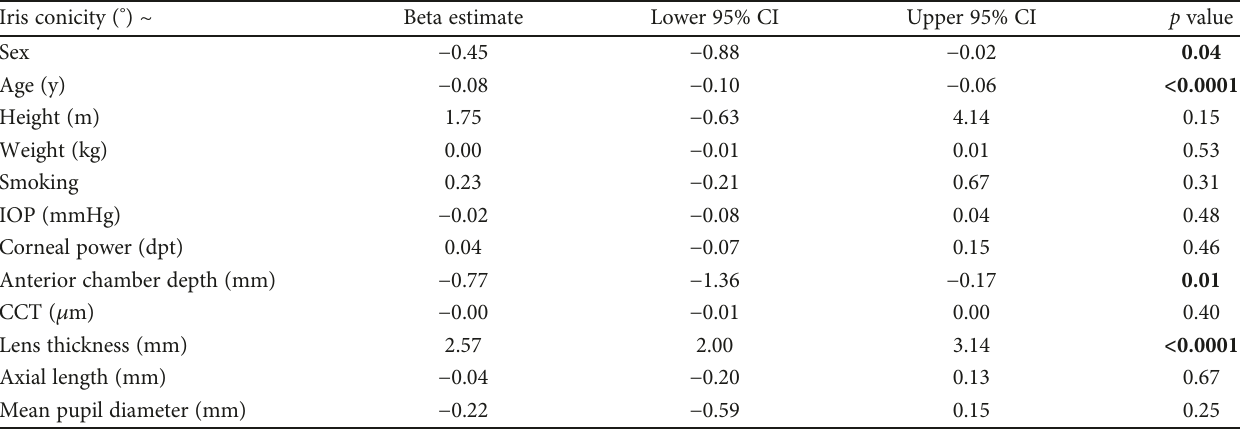
Table 4: Associations of iris conicity and anthropometric and ocular characteristics including ocular geometric parameters in the Gutenberg Health Study separated for refractive error (myopic eyes (sphere < − 0.5D), emmetropic eyes (sphere: − 0 5 D ≤ × ≤ 0 5D ), hyperopic eyes (sphere > 0.5D), and eyes with astigmatism > − 1.0D. CI: con fi dence